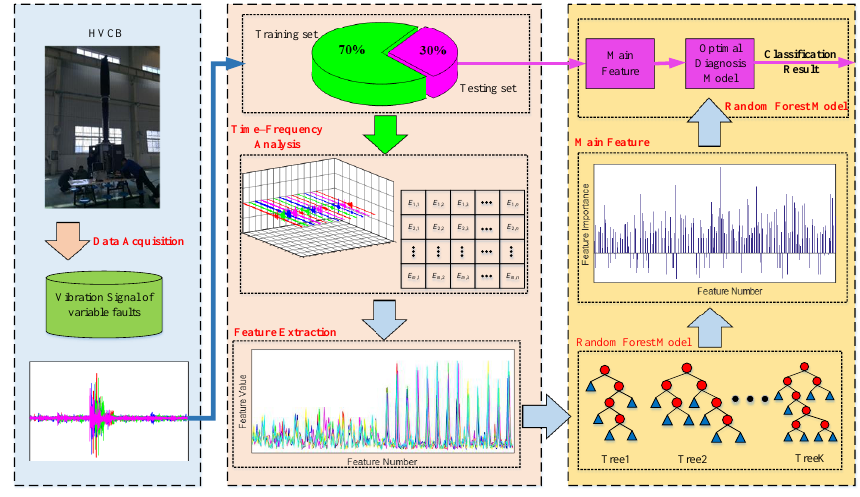
Figure 1. Structure flow of identification process.